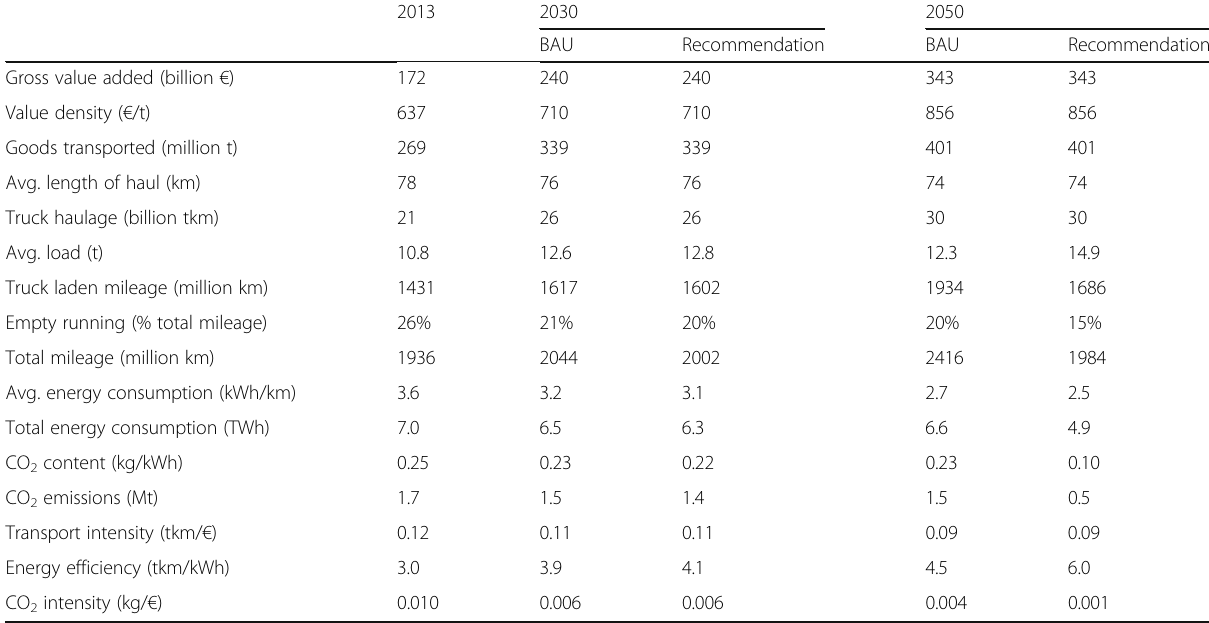
Table 4 Values of framework indicators for truck transport in BAU and recommendation scenarios in 2013, 2030 and